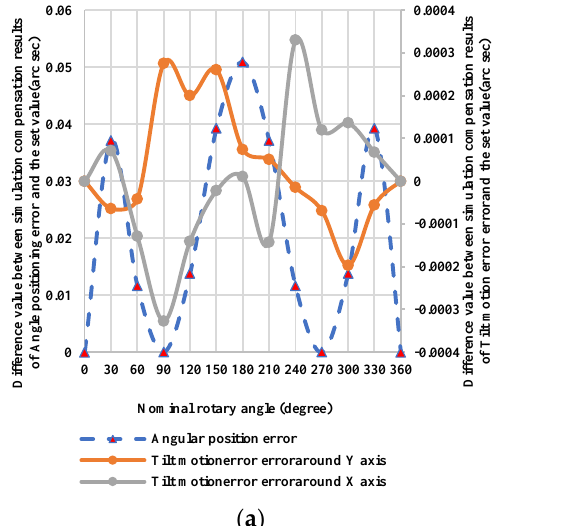
Table 2. The specific parameters of the autocollimator and laser displacement sensor.